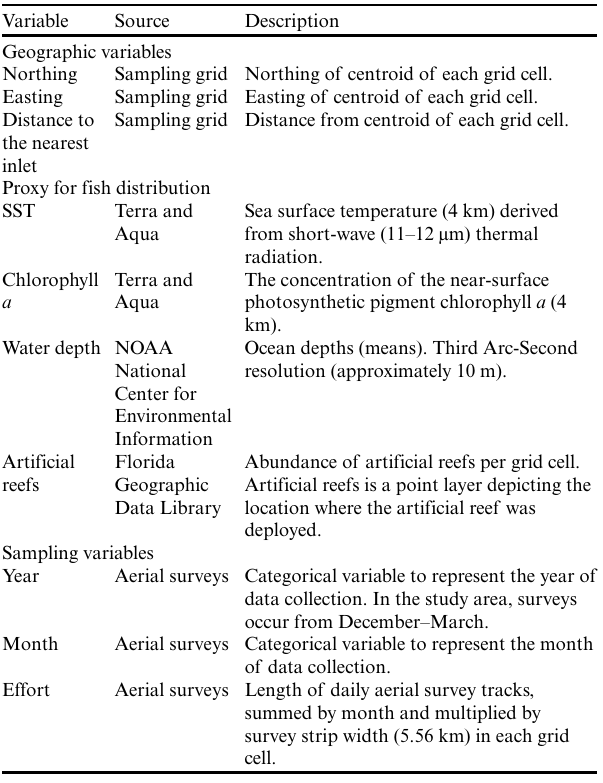
Table 1. Explanatory variables assessed to predict the